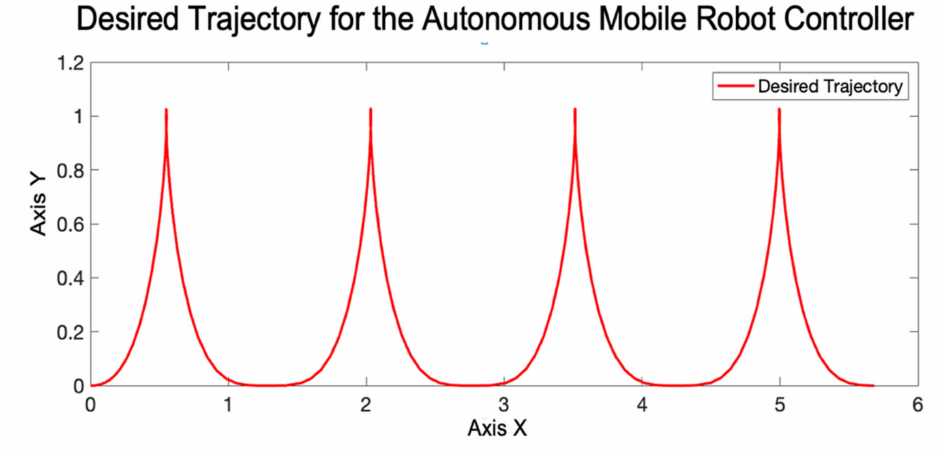
Figure 17. Reference trajectory for the